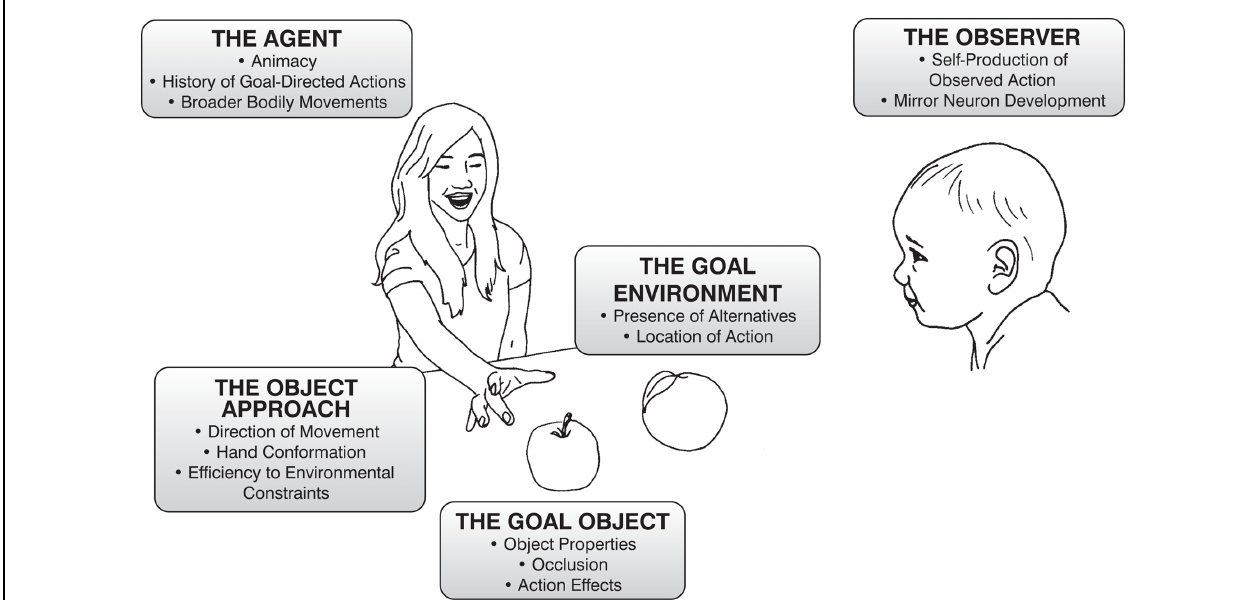
FIGURE 1 | Description of the elements of an object-directed reach that can influence infants encoding of the goal of that reach. The following paper will discuss each of the categories listed above and expand upon how the listed factors influence infant’s judgements.